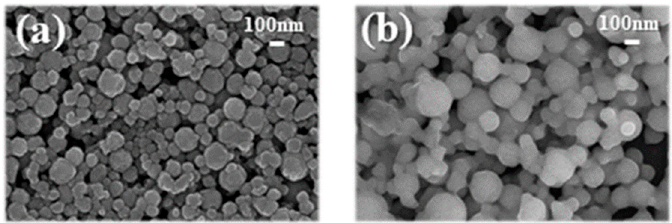
Figure 6. FE-SEM images of IPL-sinterable nano Cu ink: ( a ) w/o PVP and ( b ) with PVP.